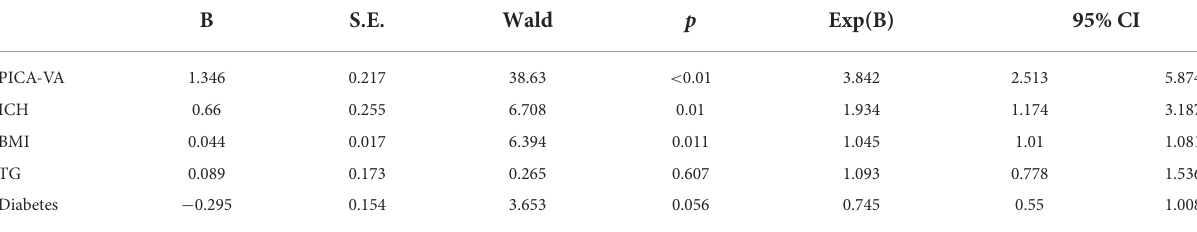
TABLE 3 Multivariate logistic regression of risk factors of vertebrobasilar